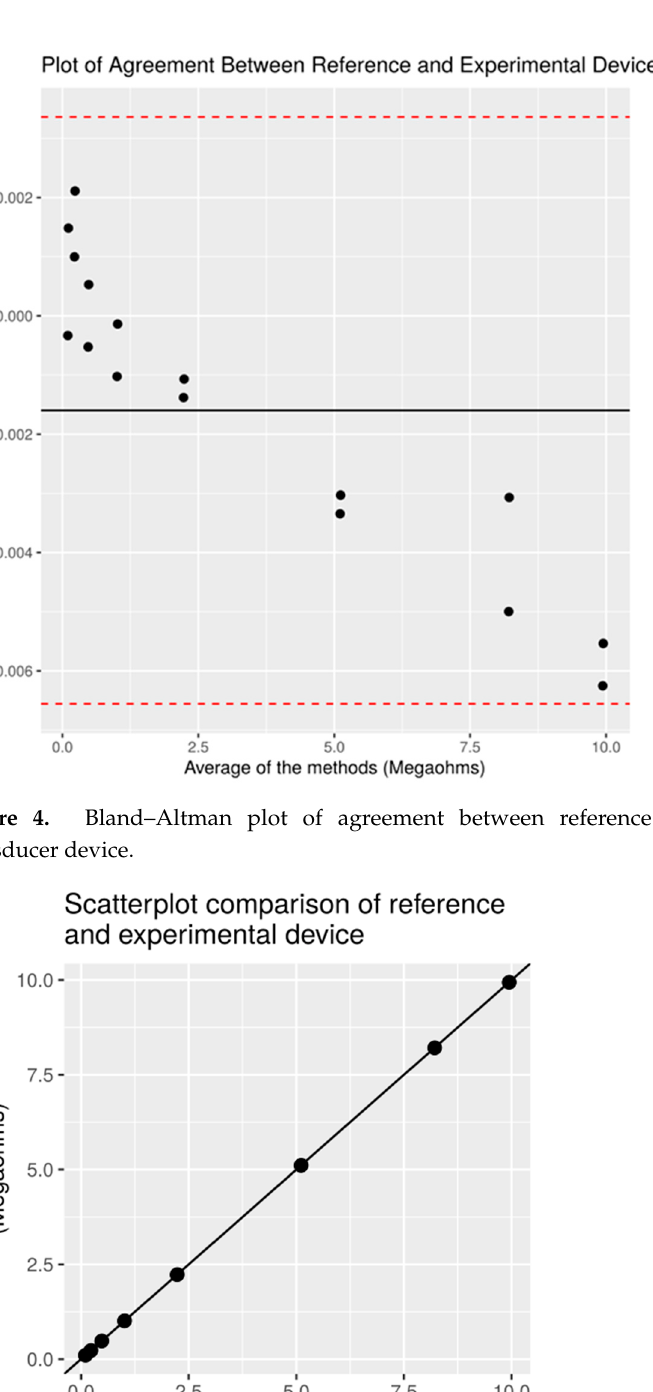
Figure 5. Scatterplot of indicated values (reference vs. experimental device) featuring line of equality.